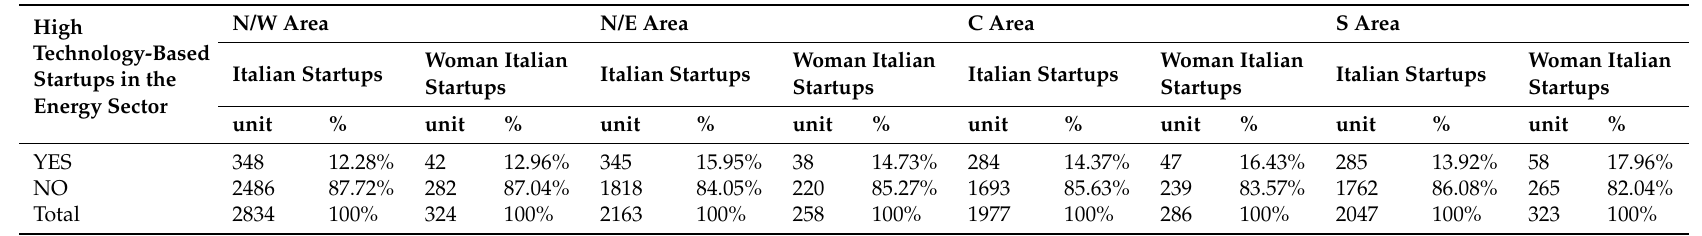
Table 13. Italian startups and Italian woman startups operating in the high technology energy sector for geographical macroarea.